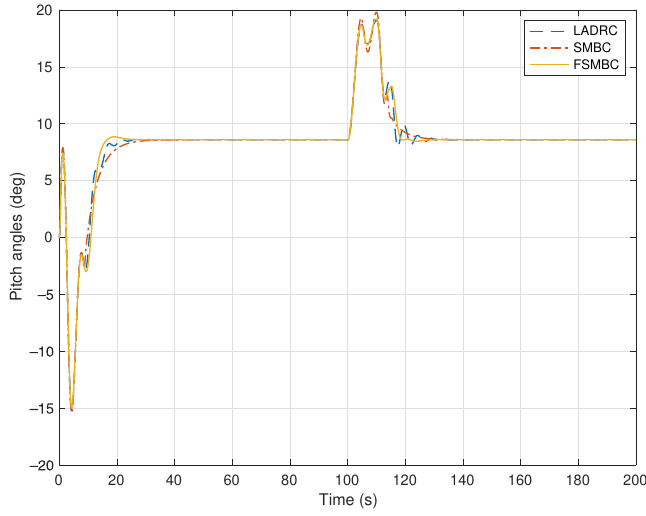
Figure 5. Simulation results of the pitch angle.